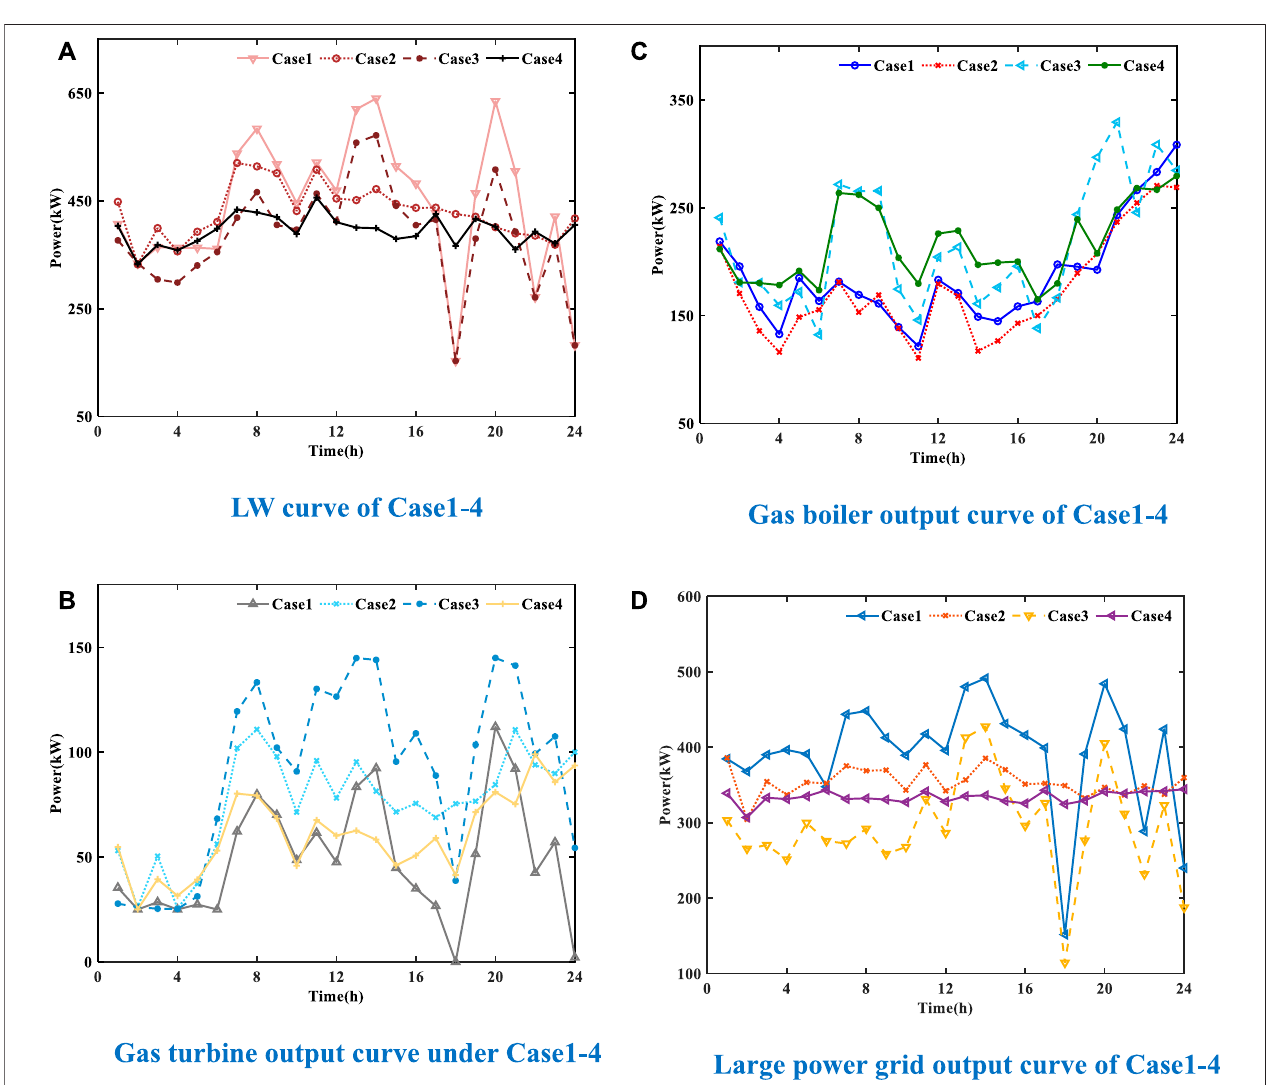
FIGURE 7 | LW curve and output curve of large power grid, gas turbine, and gas boiler of Case1 – 4. (A) LW curve of Case1 – 4. (B) Gas turbine output curve of Case1 – 4. (C) Gas boiler output curve of Case1 – 4. (D) Large power grid output curve of Case1 – 4.